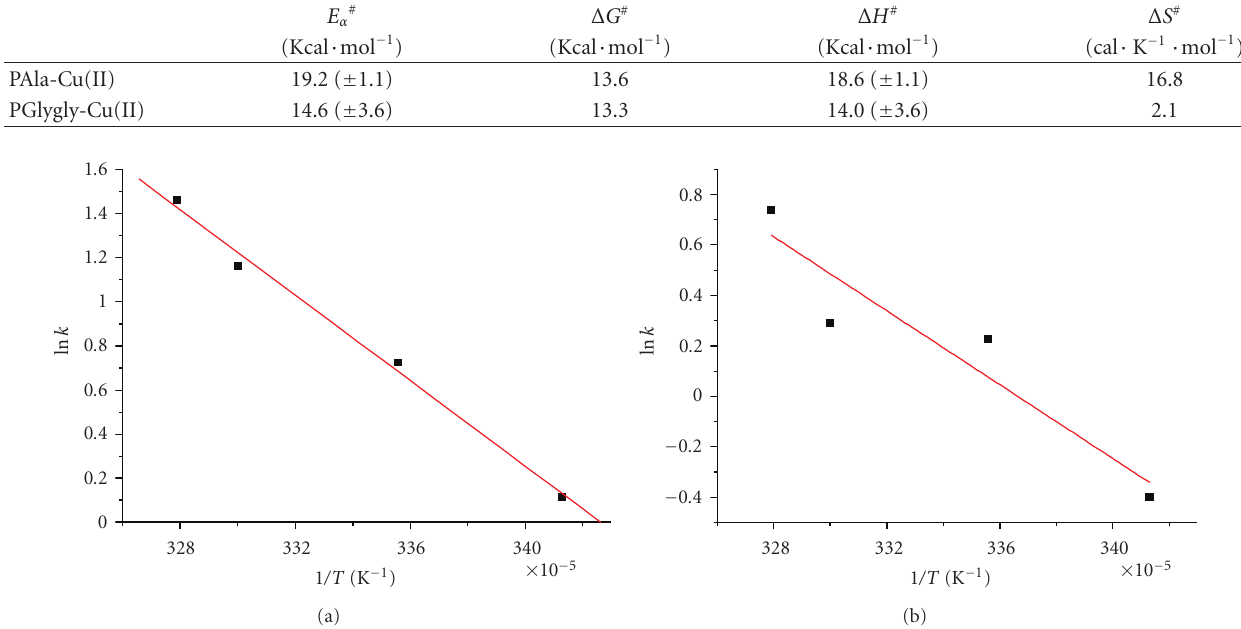
Figure 4: Arrhenius plots for the system (a) PAla-Cu(II), [PAla] = 2.0 × 10 − 3 M, [Cu 2+ ] = 5.0 × 10 − 4 M, [H 2 O 2 ] = 6 . 7 × 10 − 3 M, pH = 8 . 8 (b) PGlygly-Cu(II), [PGlygly] = 2.0 × 10 − 3 M, [Cu 2+ ] = 5.0 × 10 − 4 M, [H 2 O 2 ] = 6.7 × 10 − 3 M, pH =